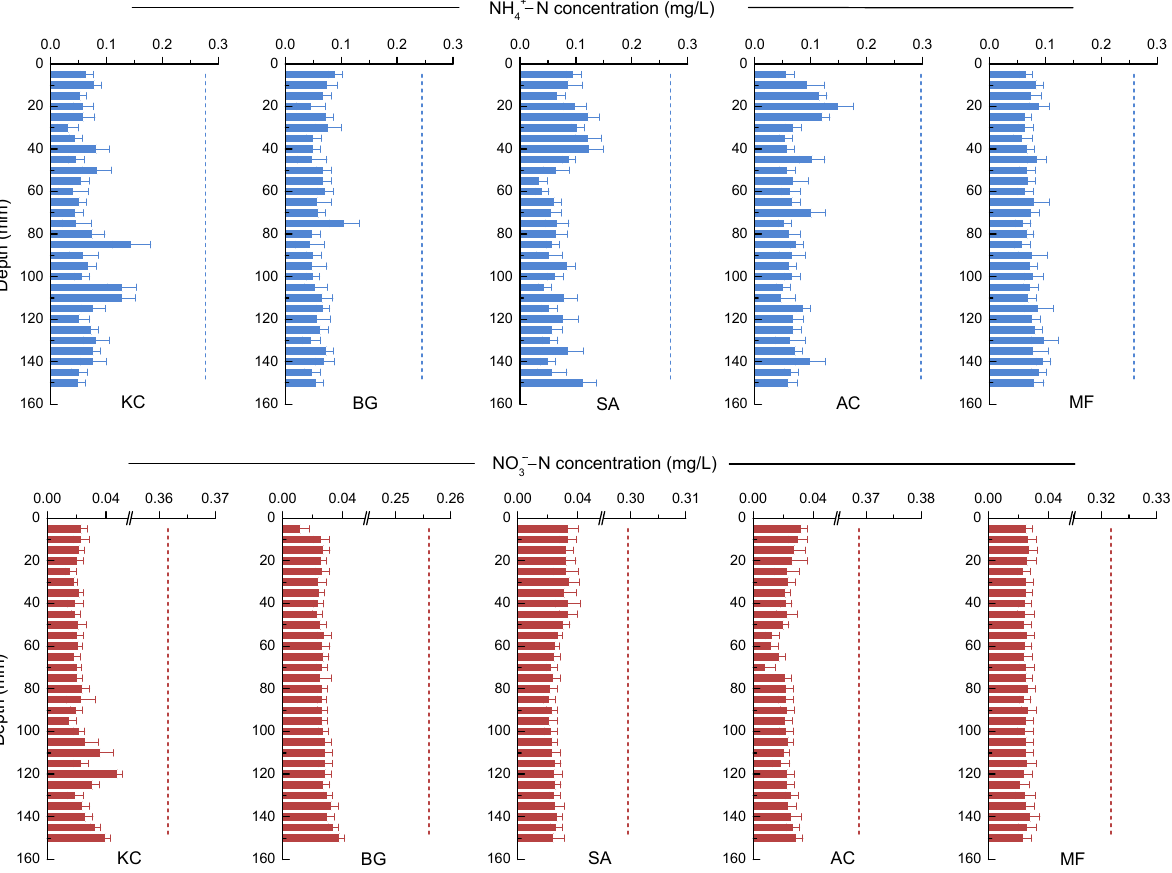
Figure 2. Vertical distribution of NH 4+ − N and NO 3 − − N in the interstitial water samples from the five sites. KC, BG, SA, AC, and MF are site abbreviations for Kandelia candel , Bruguiear gymnorrhiza , Sonneratia apetala , Aegiceras corniculatum , and mud flats, respectively. Dashed lines indicated the nitrogen concentration in the seawater from each site.